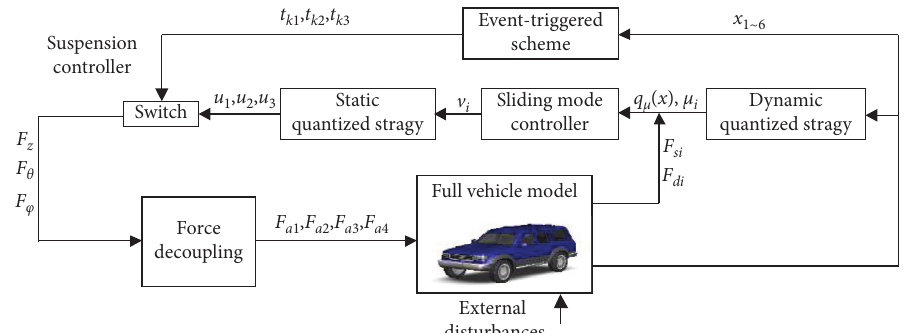
Figure 2: Diagram block of the proposed controller.